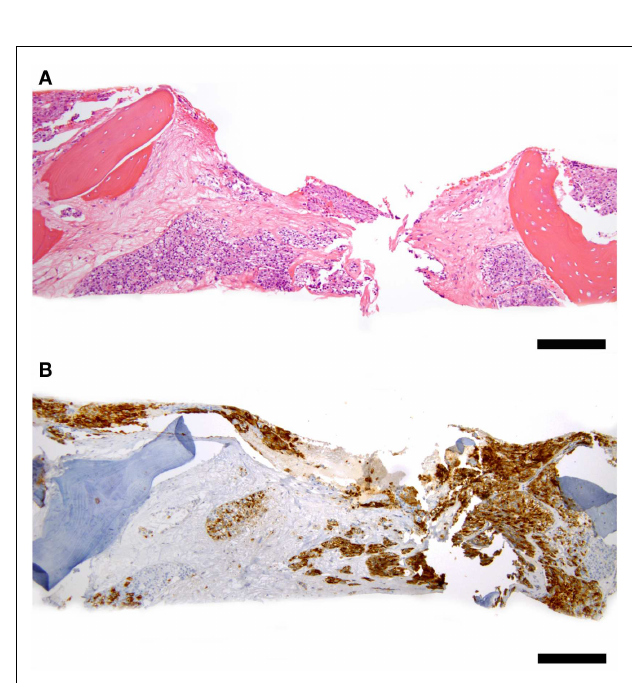
FIGURE 1 | Representative bone marrow biopsy of a patient with progressive prostate cancer and decreasing blood counts 3years after 177 Lu-J591 radioimmunotherapy, count recovery, and several subsequent therapies including chemotherapy . (A) Hematoxylin and eosin stain at 100 × total magnification low power view of bone marrow with intertrabecular marrow space entirely replaced by metastatic prostate cancer cells. (B) PSMA – 100 × total magnification low power view of same field of bone marrow replaced by tumor showing PSMA-positivity in tumor cells (brown staining); scale bars = 200 microns. Cytogenetic studies revealed normal 46, XY male karyotype; normal bone marrow biopsy control not